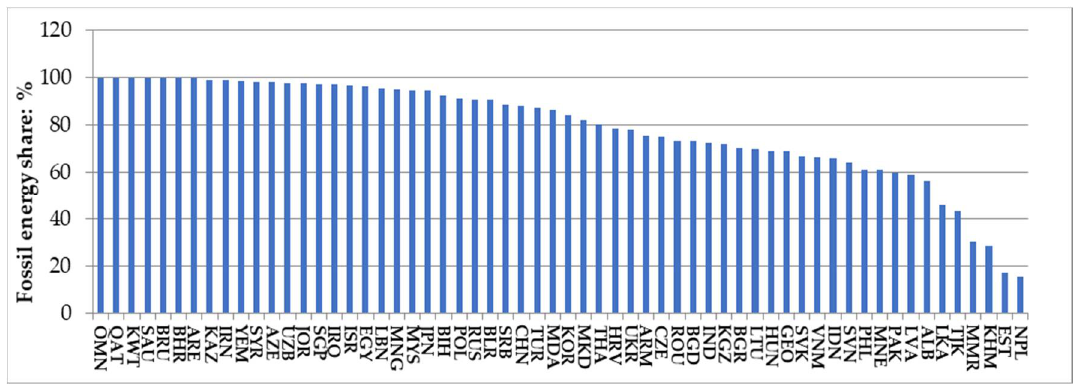
Figure 1. Percentage of fossil energy consumption in major B&R countries in 2014.